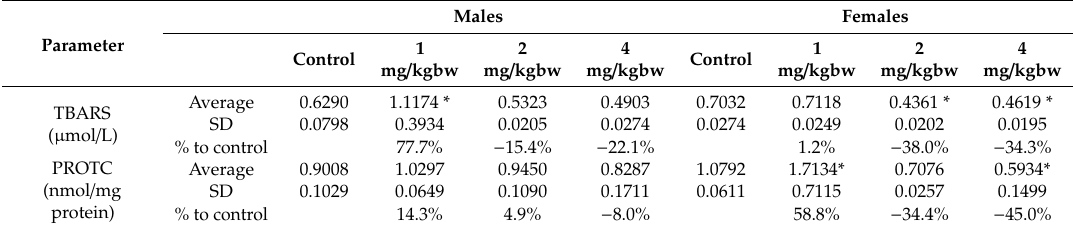
Table 3. Markers at 28 days after exposure to di ff erent concentrations of EG-AgNPs.